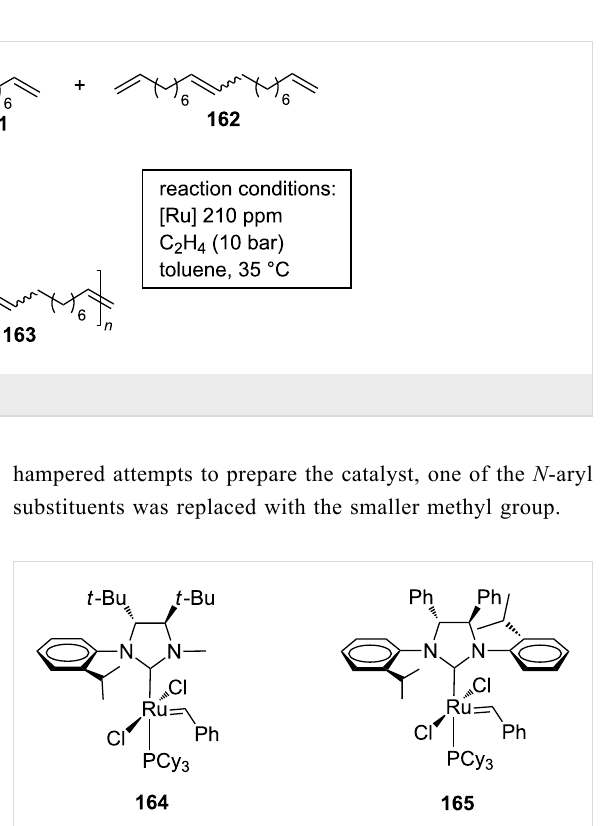
Complex 164 was obtained in poor yield (30%) and character- ized through NOE and X-ray analysis, revealing the exclusive formation of the rotational isomer in which the N -methyl lies over the carbene unit (the syn isomer, Figure 31).